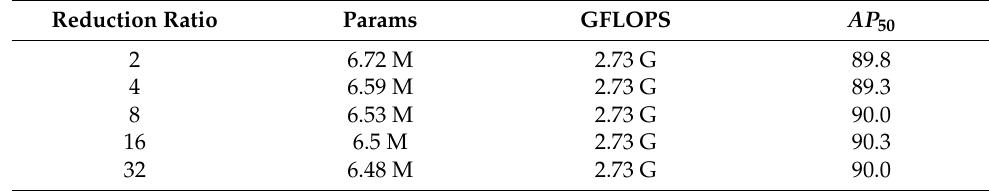
Table 5. Experiments on the reduction ratio of MLP in